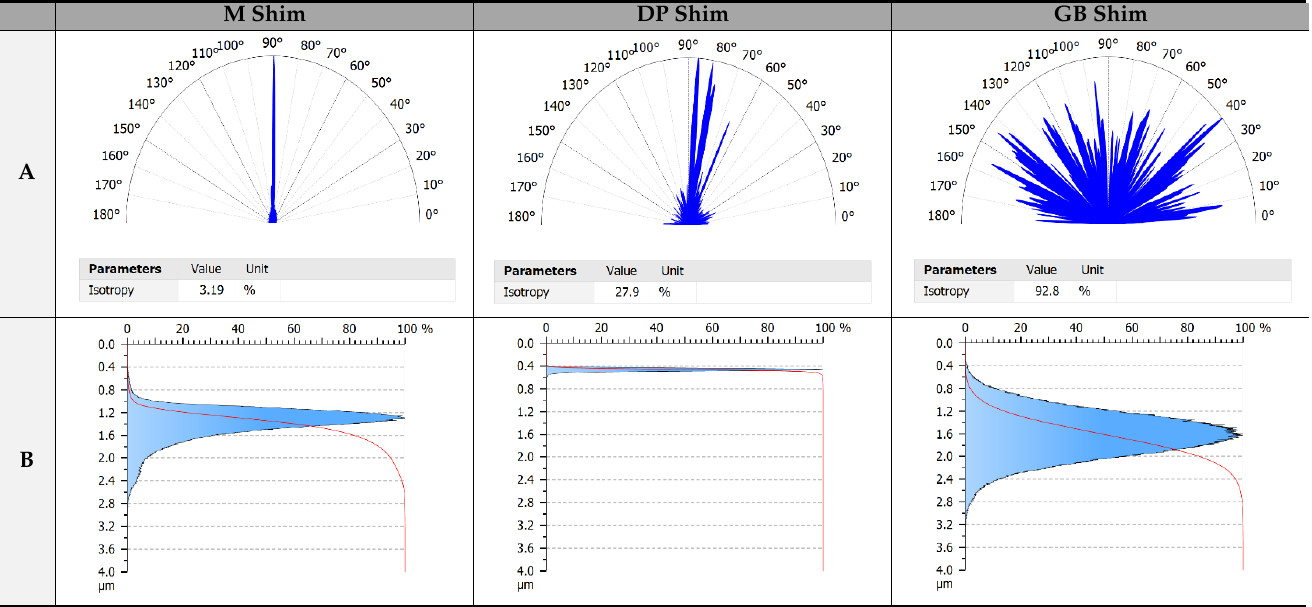
Table 2. Assessment of surface-texture character by (Row A) surface isotropy and (Row B) peak-count distribution on shim surfaces before coating.